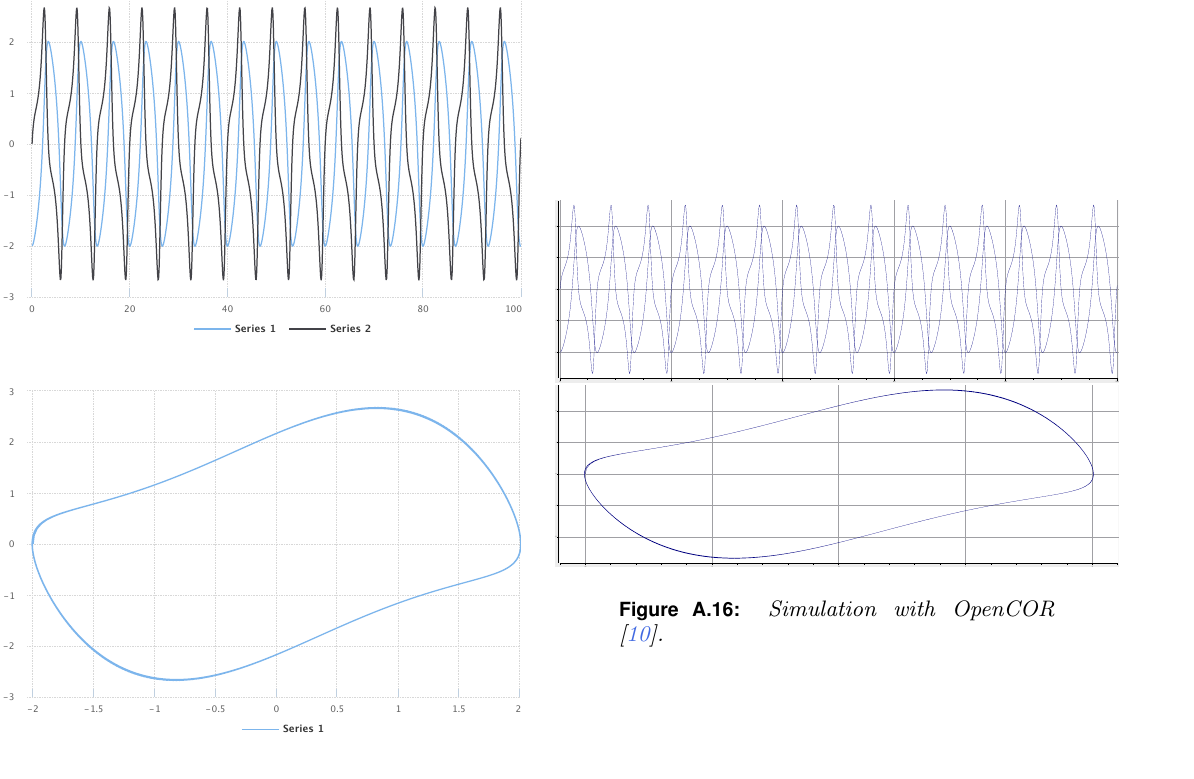
Figure A.15: The simulation result gained from the simulation description given in Listing A.9. Simulation with SED-ML web tools [2].